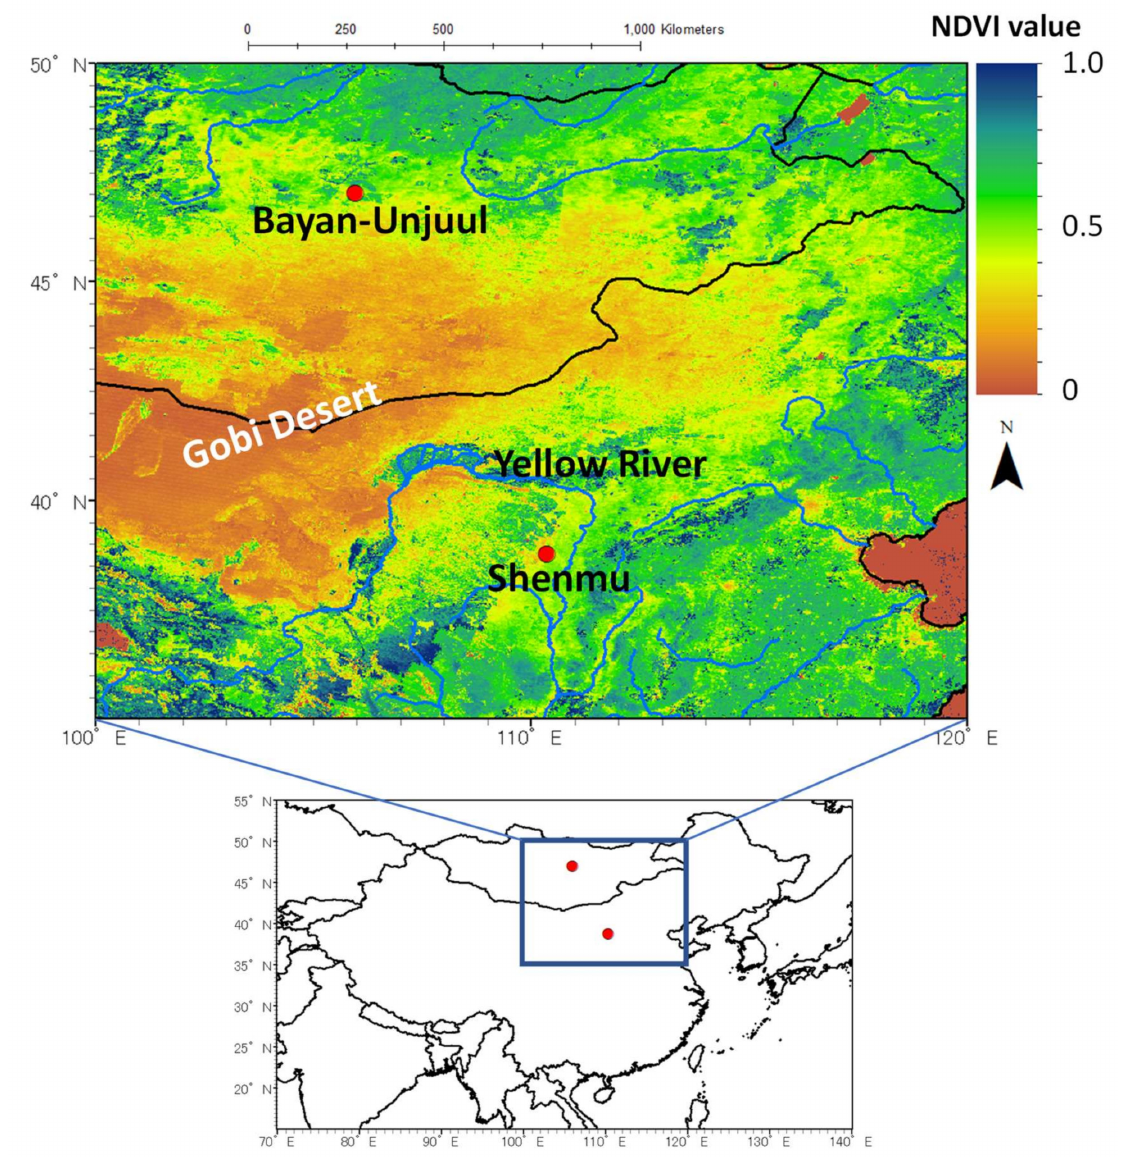
Figure 1. Locations of Shenmu, China, and Bayan-Unjuul, Mongolia, with the distribution of the NDVI in August